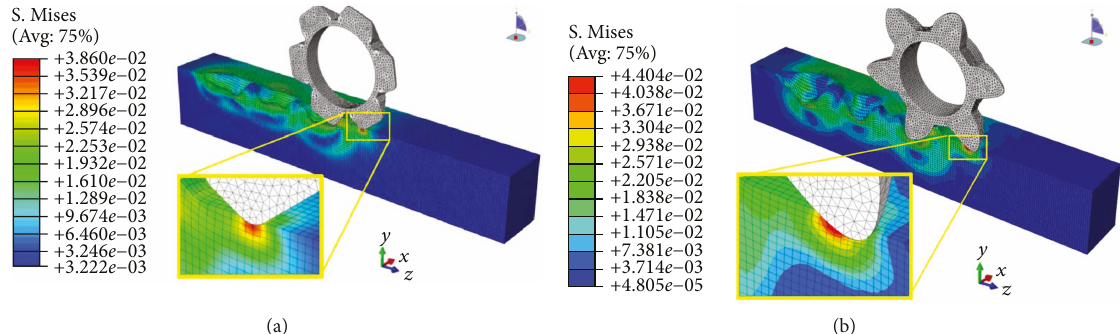
Figure 14: Impacting stage. (a) Conventional toothed wheel. (b) Bionic toothed wheel.